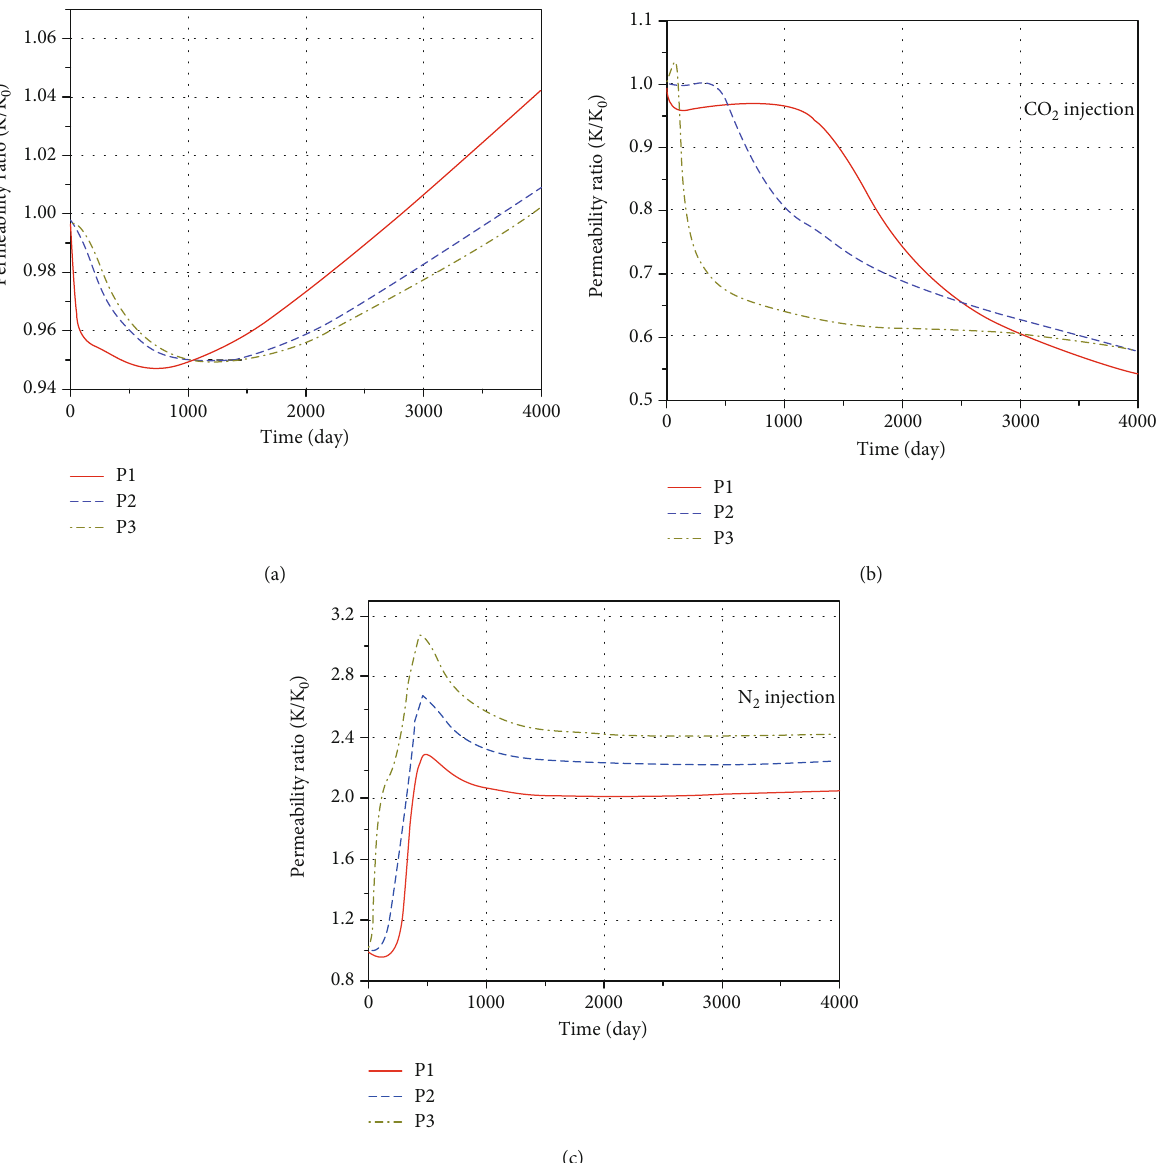
and N injection under di ff erent reference points (P1, P2, and P3). 2 2